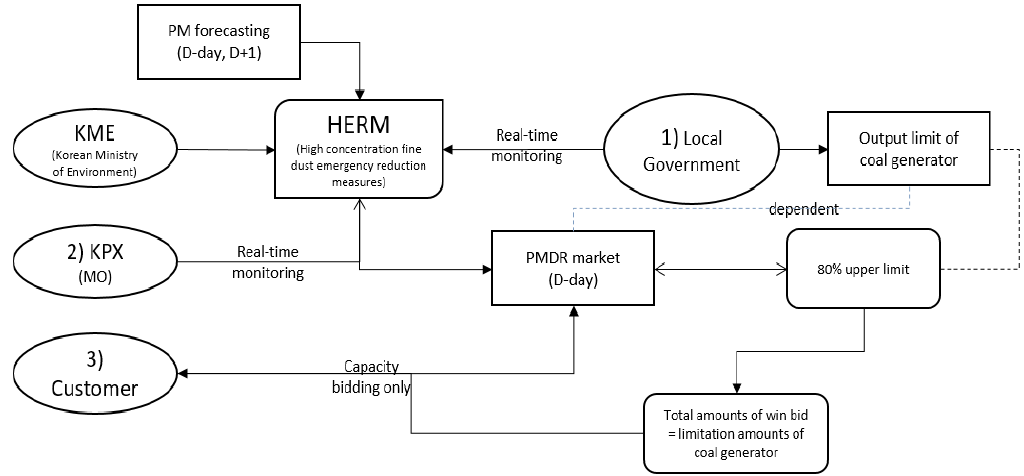
Figure 2. Flowchart for particulate matter demand response (PMDR) operation.